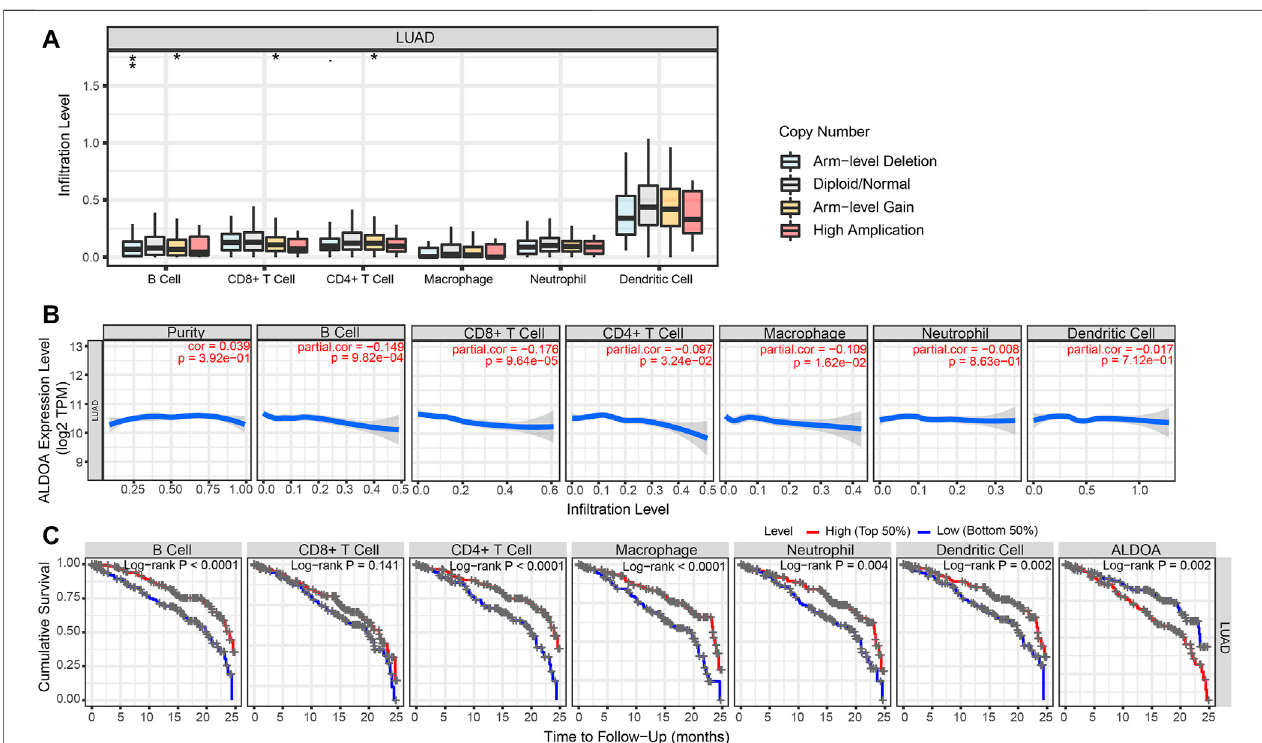
FIGURE 11 | Immune cell in fi ltration of ALDOA in lung adenocarcinoma ( A ) The “ SCNA ” module analysis indicated that the copy number alterations of ALDOA were correlated with three immune cell in fi ltration levels (B) The “ Gene ” module analysis indicated that there was no correlation between ALDOA expression and tumor purity. However, ALDOA expression was negatively correlated with in fi ltrating levels of B cells, CD8 + T cells, CD4 + T cells, and macrophages ( C ) Low levels of B cells, CD4 + T cells, macrophages, neutrophils, and dendritic cells were associated with poor prognosis of lung adenocarcinoma